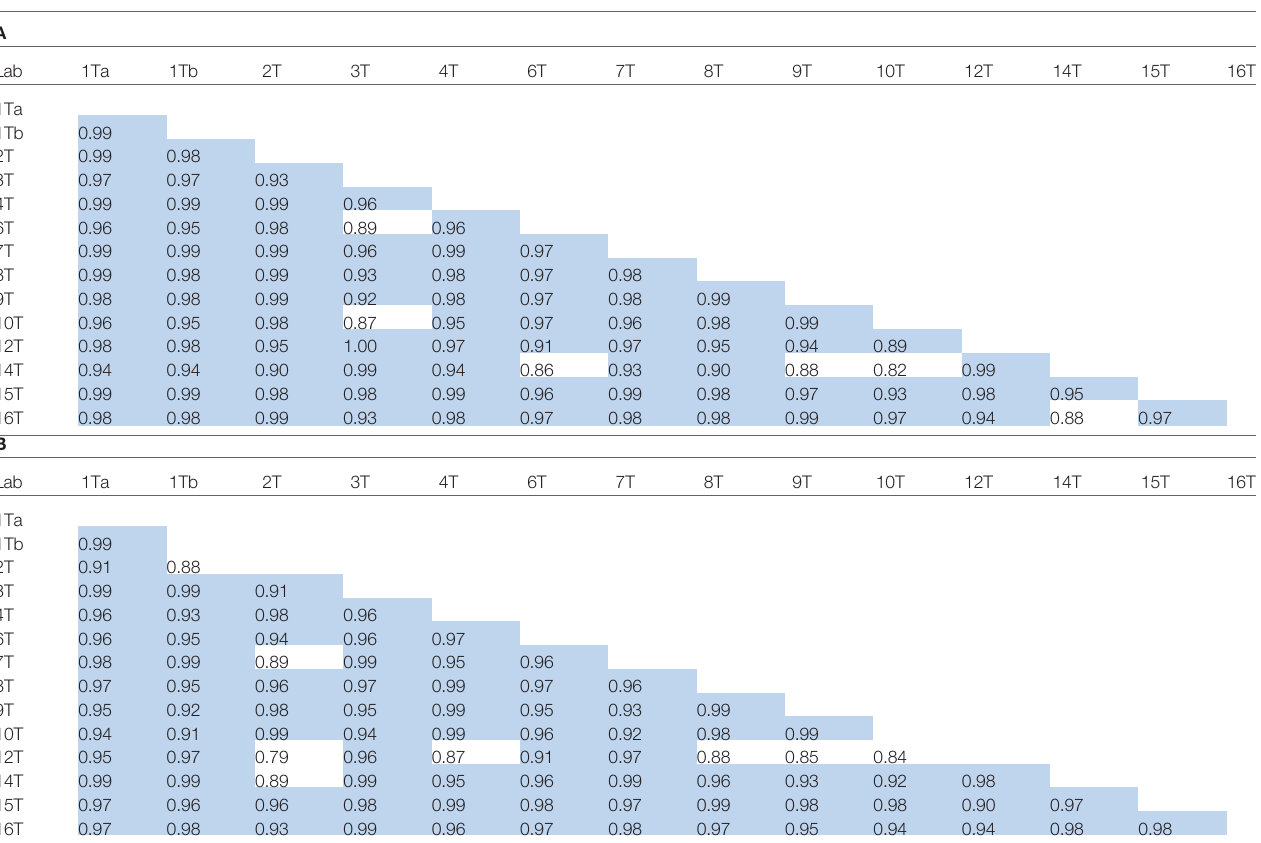
Shaded boxes represent > or equal to 90%